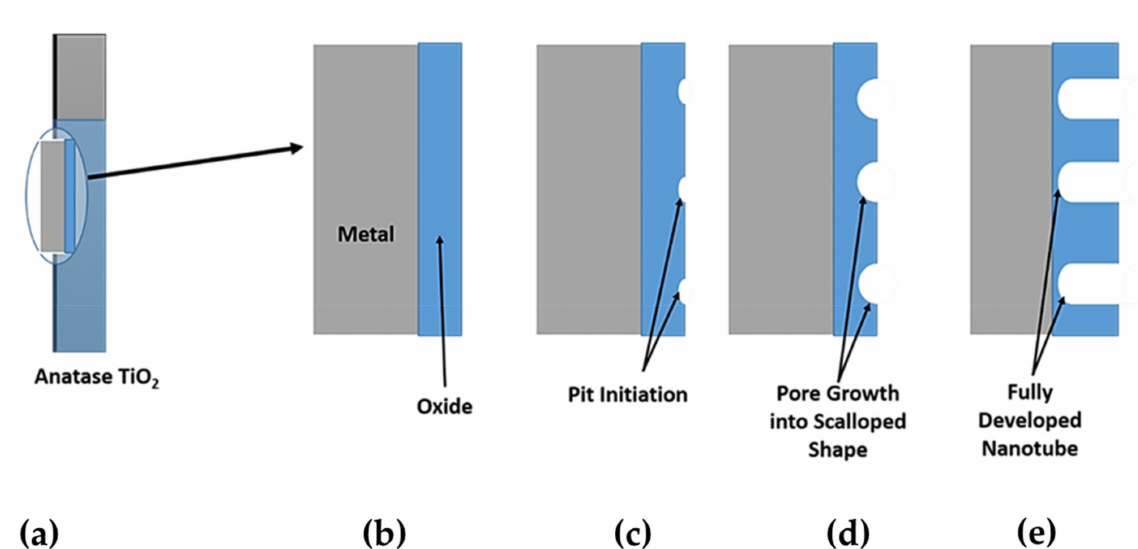
Figure 15. ( a ) Anatase TiO 2 (large scale). ( b ) The formation of a compact oxide layer. ( c ) The initiation of pits on the oxide layer. ( d ) Pore evolved into a scalloped shape. ( e ) A fully developed nanotube